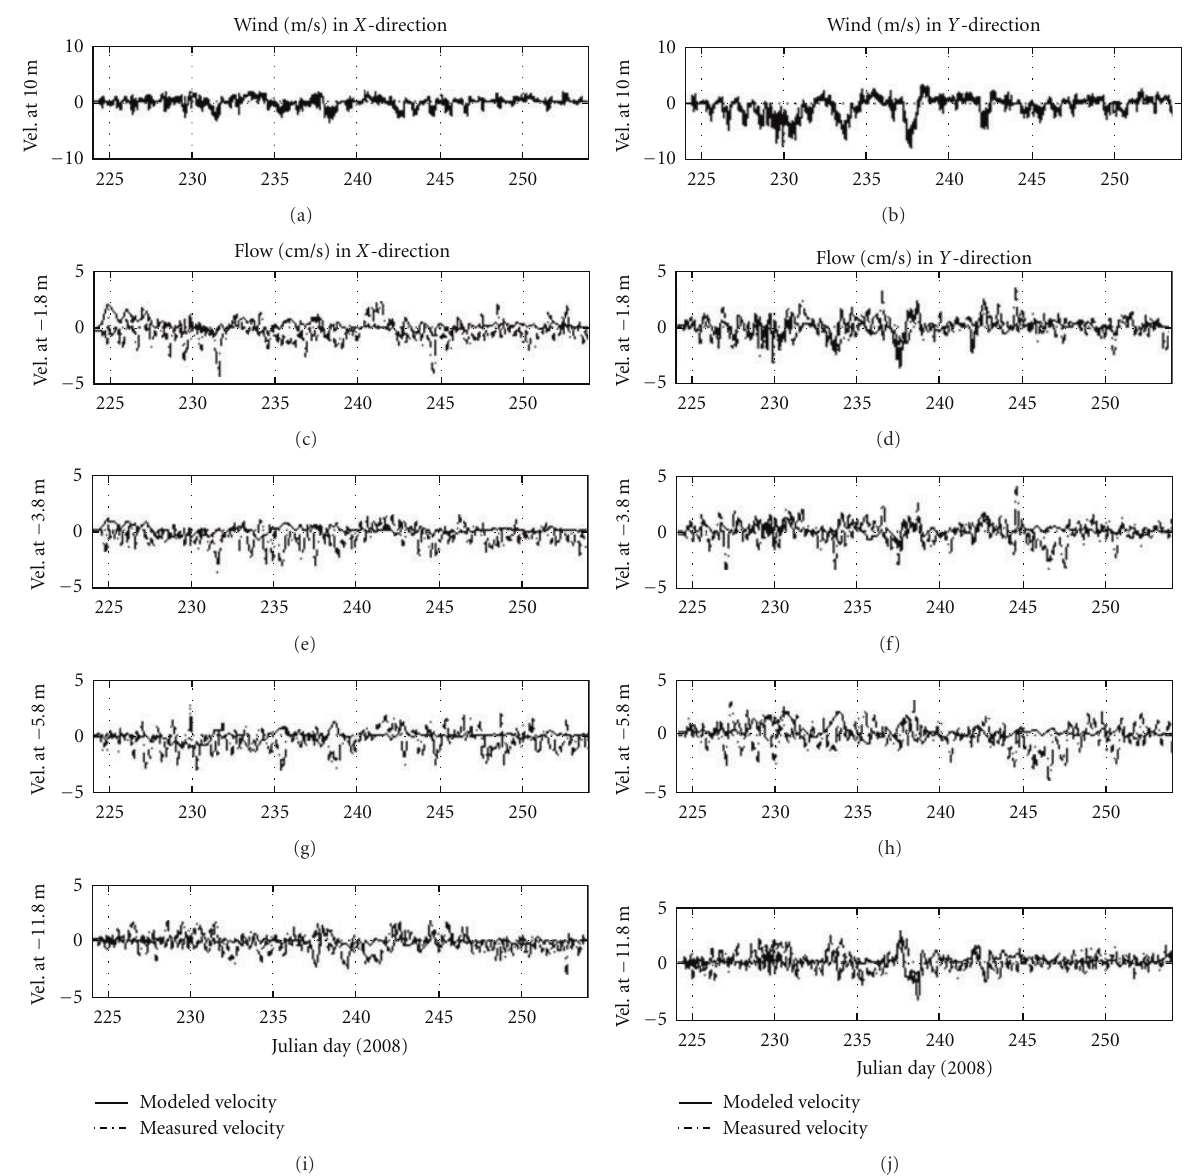
Figure 8: Comparison of the modeled and measured flow velocities at di ff erent water depths; the modeling results are from the simulation with a finer model mesh as shown in Figure